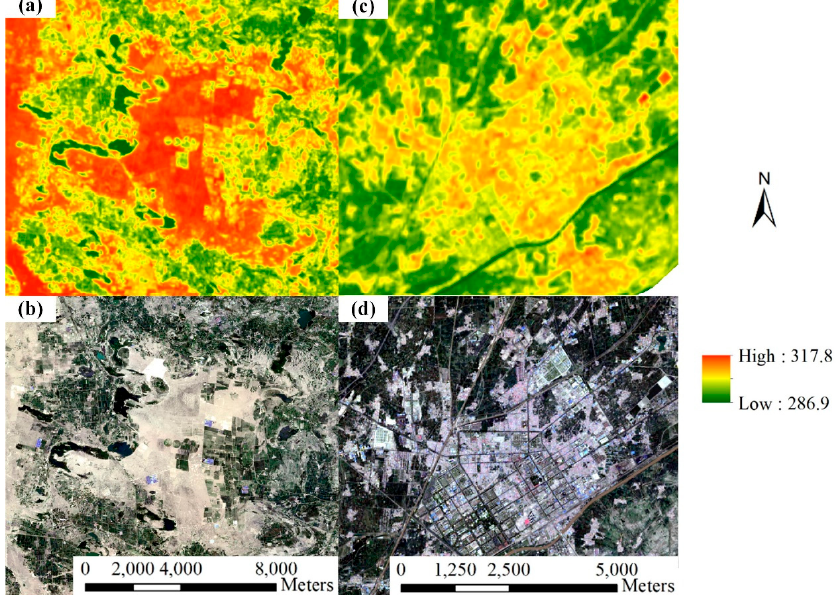
Figure 6. Example of the difference in brightness temperature (K) between the ( a , b ) desert and ( c , d ) residential areas (Landsat OLI imagery collected on 10 April 2019). ( a , c ): brightness temperature imagery, and ( b , d ): composed RGB imagery.